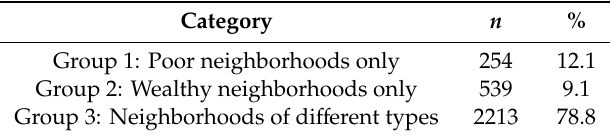
Table 1. Distribution of cumulative exposure